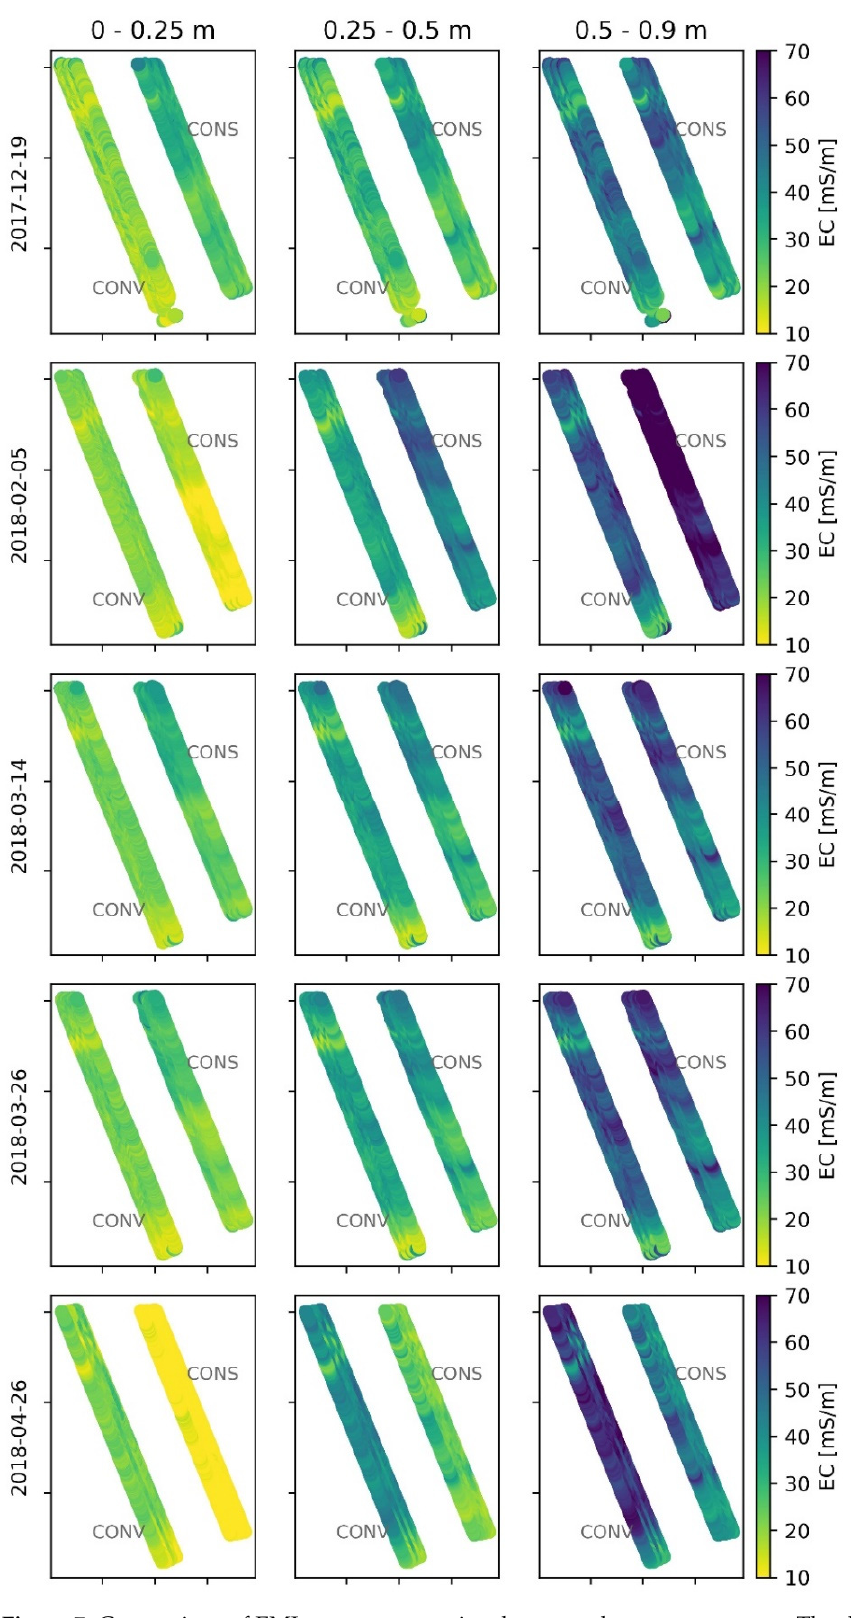
Figure 7. Comparison of EMI response over time between the two treatments. The three columns correspond to the three layers (plus infinite subspace below) used for the EMI inversion.